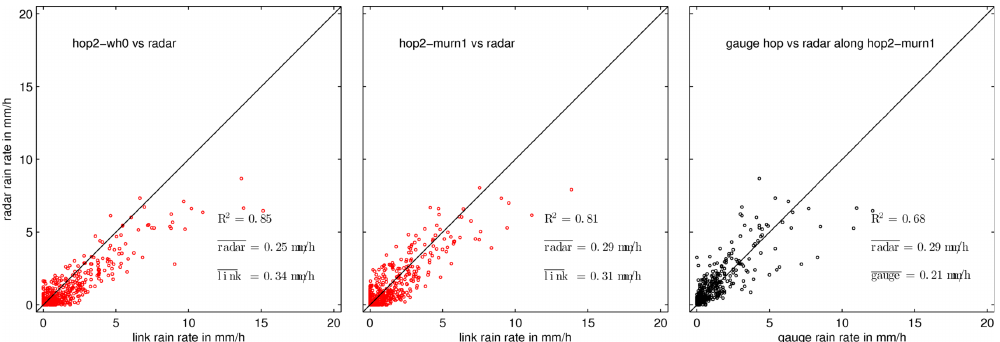
Fig. 9. Scatter plots for continuous hourly microwave link rain rate observation and DWD weather radar data along the links for the period from July 2010 to October 2010. The plot on the right gives a comparison of data from the rain gauge at Mount Hoher Peißenberg and the radar along the link hop2-wh0